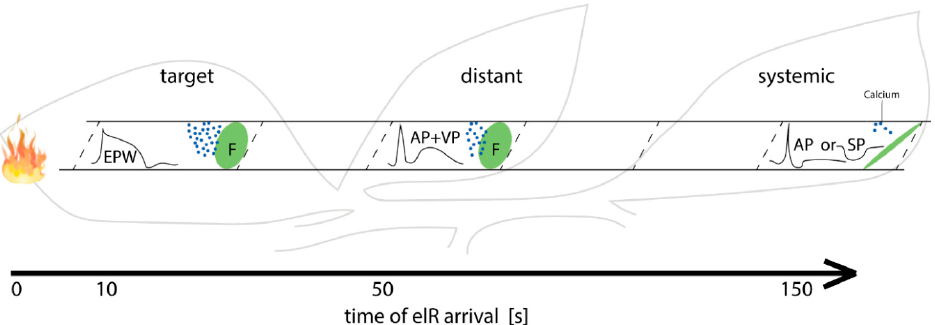
Figure 6. Schematic drawing of the events in target, distant and systemic leaflets after burning. In target leaflet the burning stimulus induces an electropotential wave (EPW = AP + VP) that results in the gating of Ca 2+ -specific channels and therefore in forisome (F) dispersion. With increasing distance, different propagation velocities separate the recordings of AP and VP, while the VP-induced depolarization is reduced. In systemic leaflets the VP is completely lost and only the AP or SP can be detected, probably since too few Ca 2+ ions are mobilized.